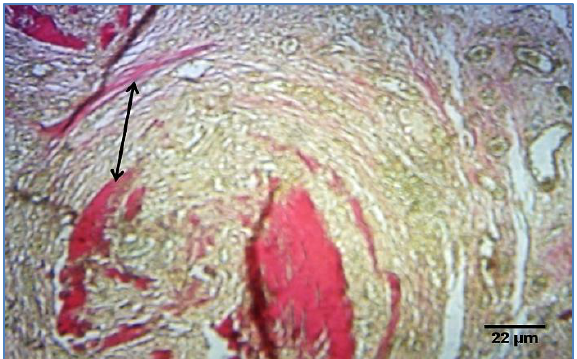
Figure, 8: Shows fibrous tissue around suture material (arrow). (Van Gieson’sstain). (grade, 1), 30th day post- operation, group